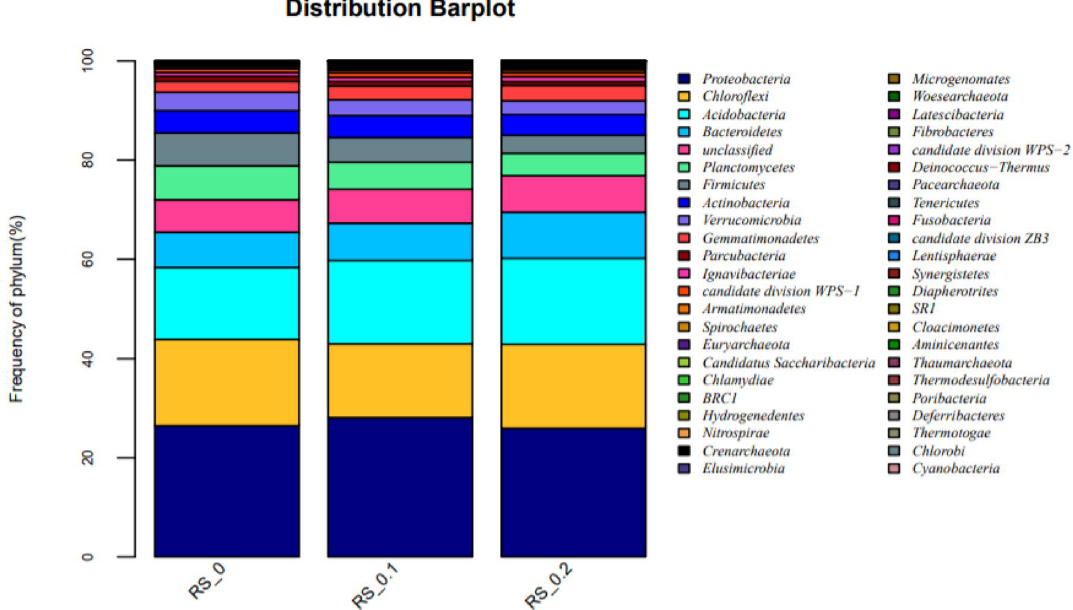
Figure 3. Relative abundance (%) above 1% of different phylum in rhizosphere soil treated with 5 mg/kg Cd under different S fertilization treatments. Others include bacteria with relative abundance < 1%.